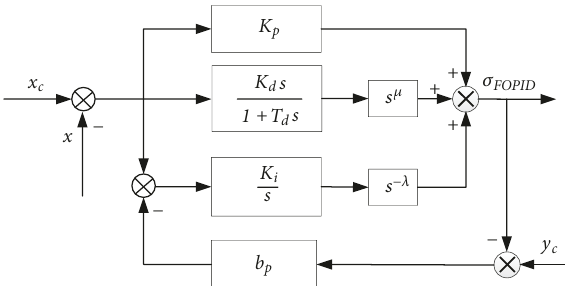
Figure 1: The structure of the FOPID controller for pumped turbine governing